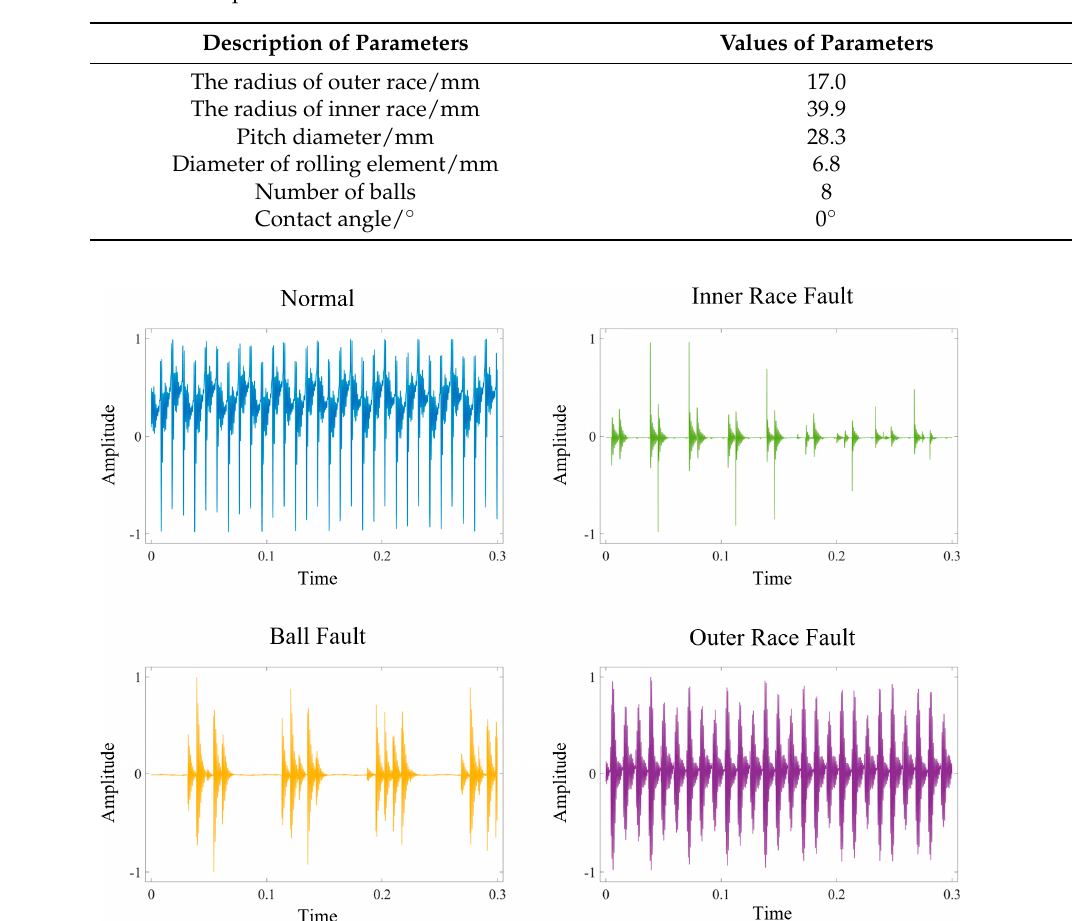
Figure 2. Schematic of the local defect area: ( a ) Outer race fault, ( b ) Inner race fault, ( c ) Ball fault. Table 1. Main parameters of 6203.